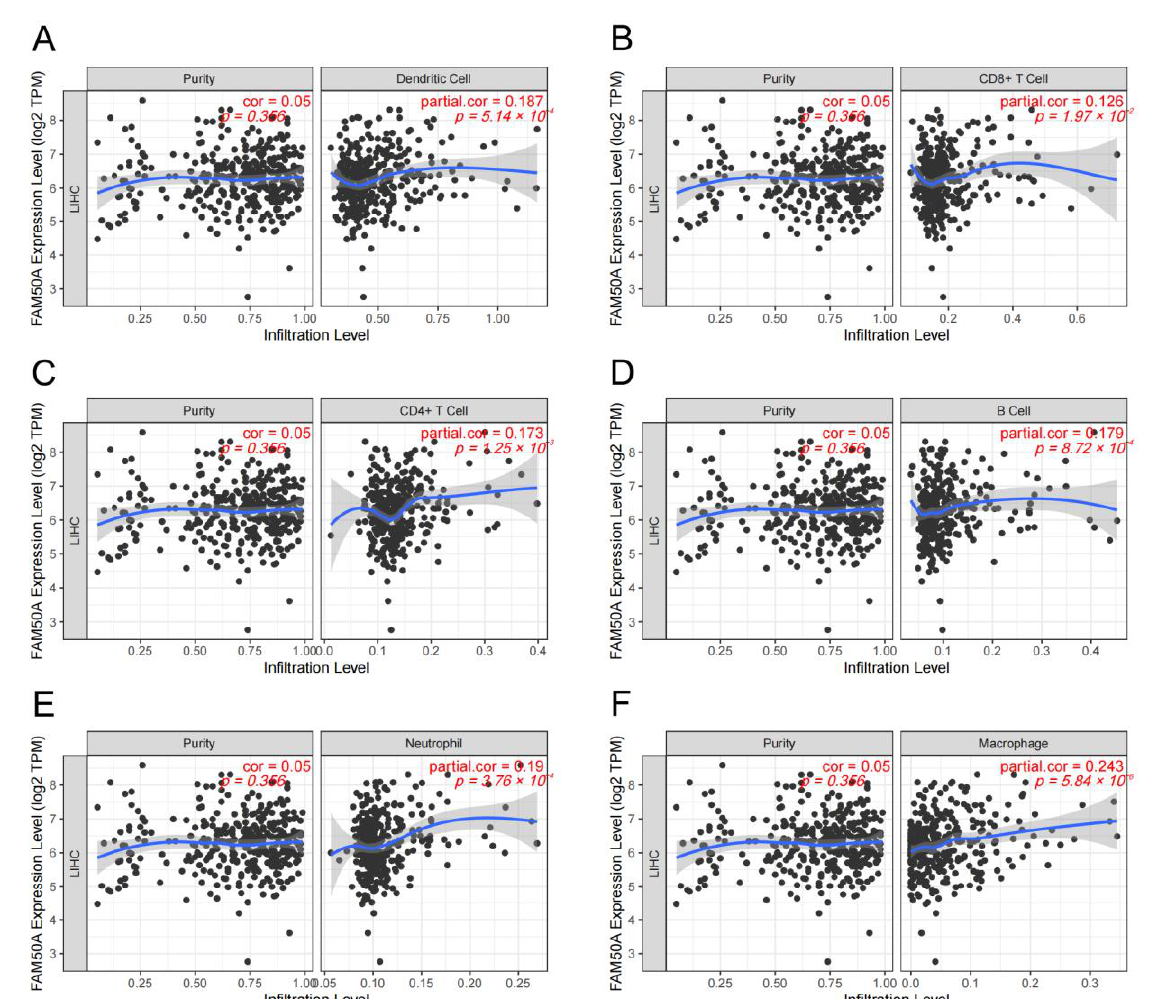
Figure 3. Correlation between FAM50A and immune cell infiltration levels in HCC. We analyzed the correlation between the expression of FAM50A and the infiltration of multiple immune cells in the TIMER database. ( A ) Dendritic cells. ( B ) CD8+ T cells. ( C ) CD4+ T cells. ( D ) B cells. ( E ) Neutrophils. ( F ) Macrophages.